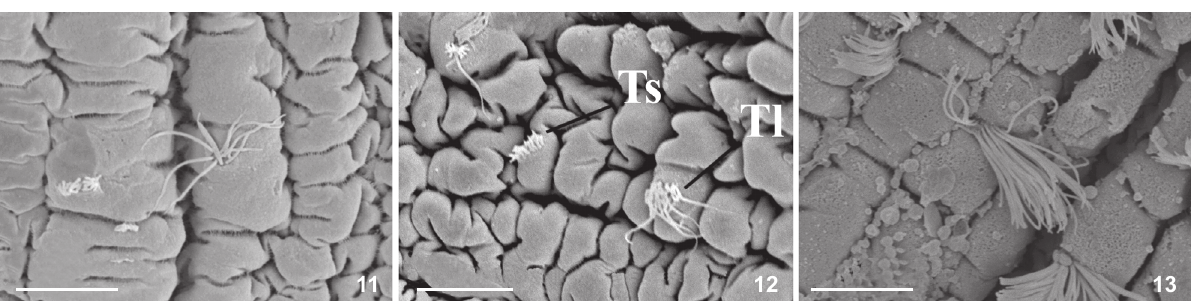
Figures 11-13. Tellina lineata . Scanning electron microscopy of the cilia types: (11) tuft of few long cilia on the inner epithelium of the inhalant siphon; (12) tufts of short and long cilia of the inhalant siphon; (13) Tuft of long cilia of the exhalant siphon. (Tl) Tuft of long cilia, (Ts) tuft of short cilia. Scale bars: 10